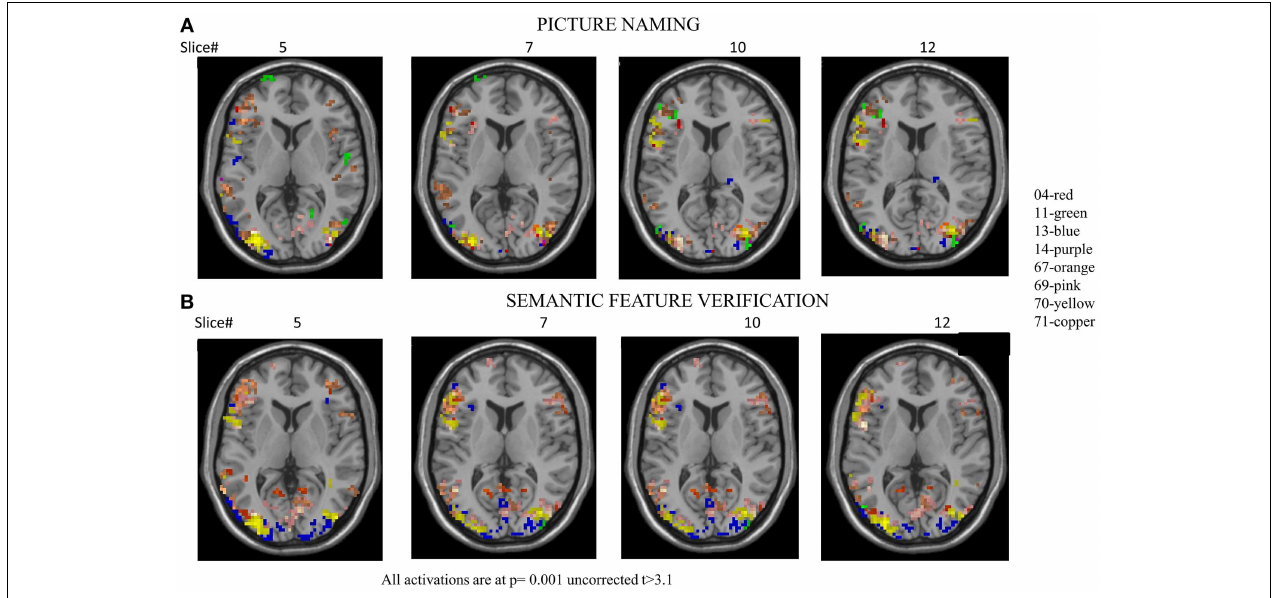
FIGURE 3 | (A) Overlap activation maps of the eight healthy controls for picture naming task. (B) Overlap activation maps of the eight healthy controls for the semantic feature verification task. The voxels are at threshold based on T > 3 . 10 , p = 0 . 001 . See Tables 4 , 5 for individual thresholded activation.